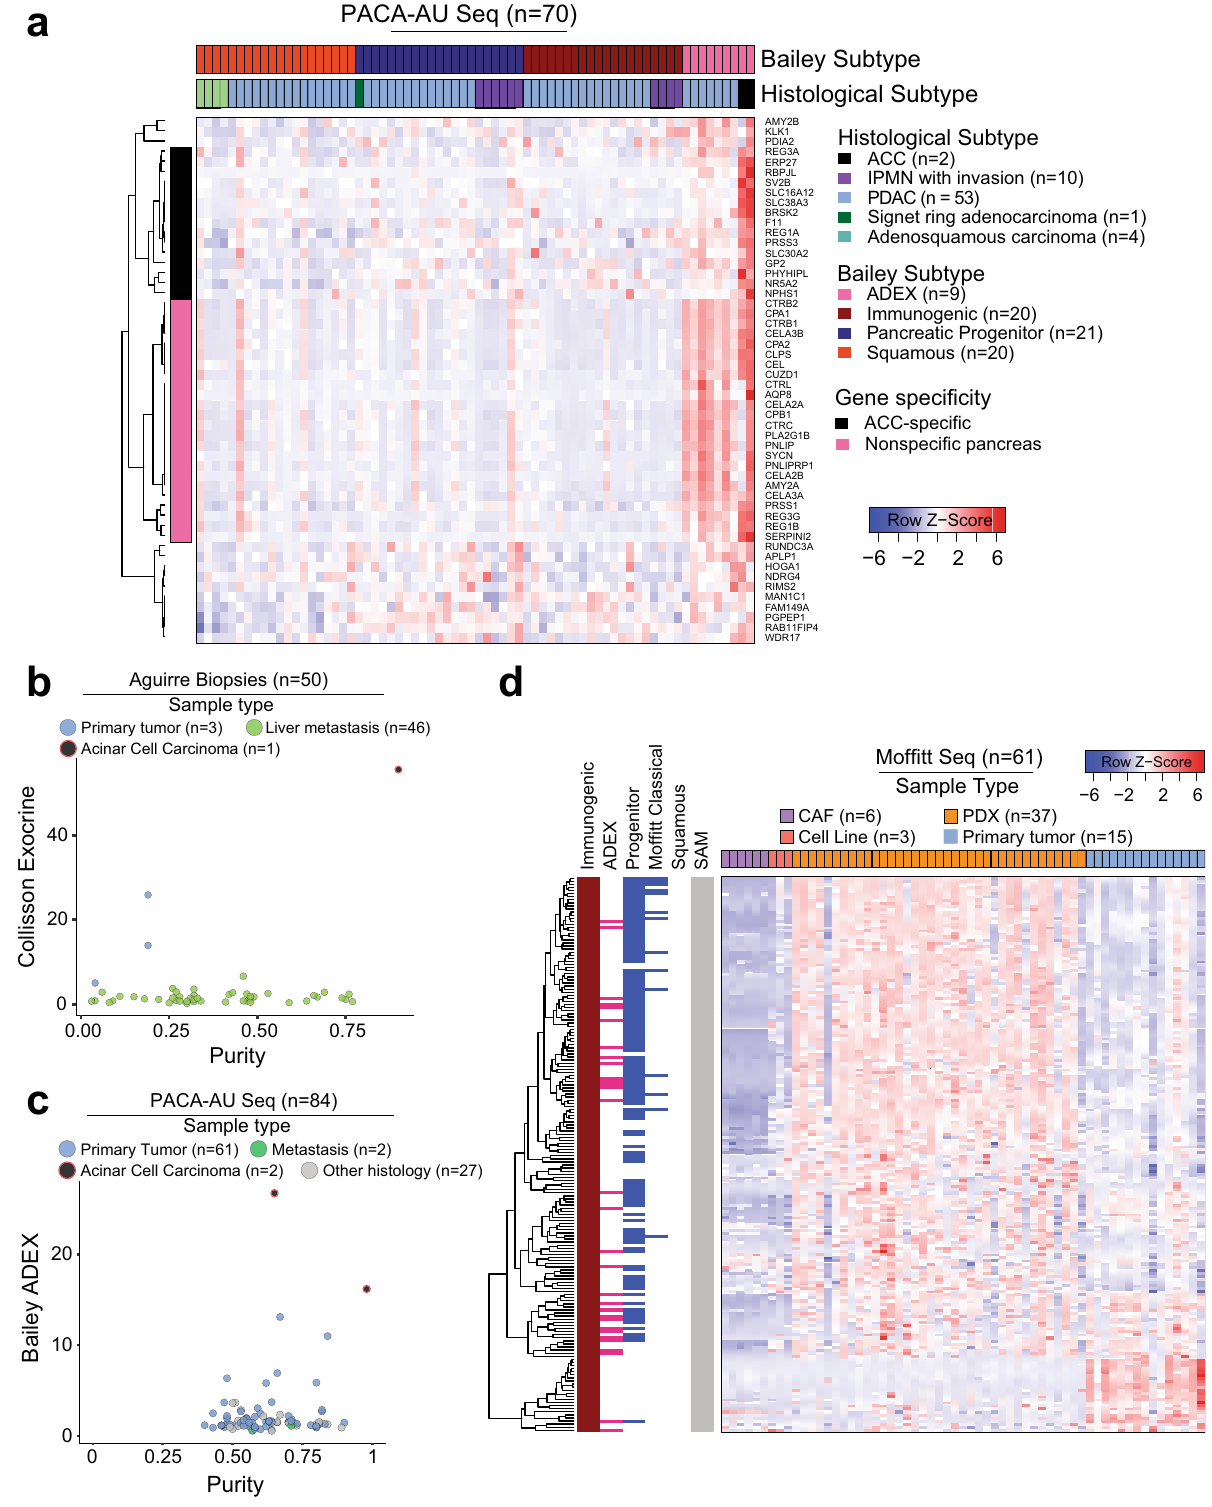
Fig. 3 Subsets of the ADEX, Exocrine, and Immunogenic gene signatures mark non-adenocarcinoma samples. a The Bailey ADEX geneset is comprised of genes that speci fi cally identify Acinar Cell Carcinomas (black), genes that appear to be more highly expressed in the ADEX subtypes yet are conserved in non-ADEX samples (light pink), and genes that are nonspeci fi c to a known sample type (uncolored). b , c High-purity samples from core needle biopsies or primary tumor samples marked by high expression of Exocrine or ADEX expression, respectively, were histologically identi fi ed as Acinar Cell Carcinomas. d The subset of genes from the Immunogenic geneset that is highly expressed in PDXs is also found in the Bailey ADEX (pink), Pancreatic Progenitor (blue, left), and Mof fi tt classical (blue, right) signatures, while genes exclusive to the Immunogenic subtype are not expressed in